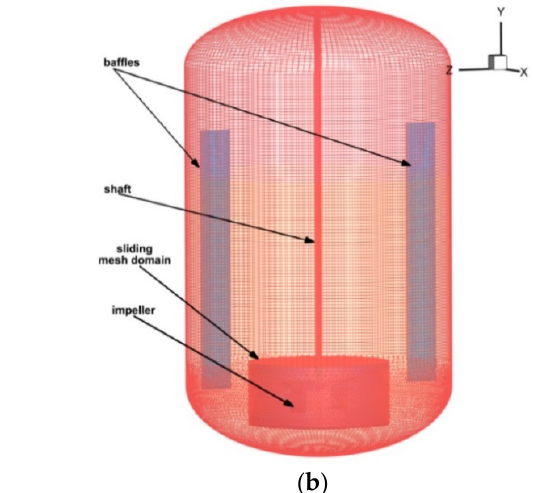
Figure 2. Computational domain: ( a ) components of the reactor; ( b ) mesh of the computational domain.